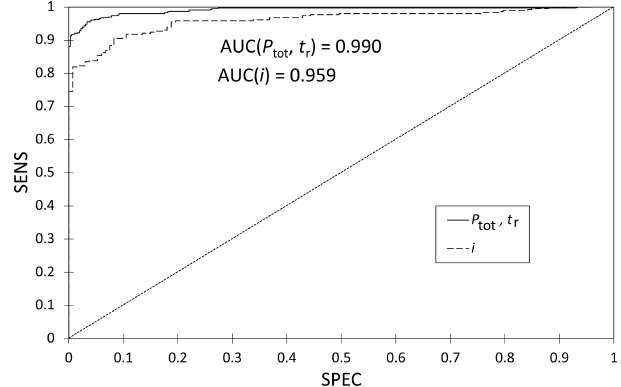
Figure 5. Relation SENS = f (SPEC) for the logit curves p = f (i) and p = f (P tot ,t r )